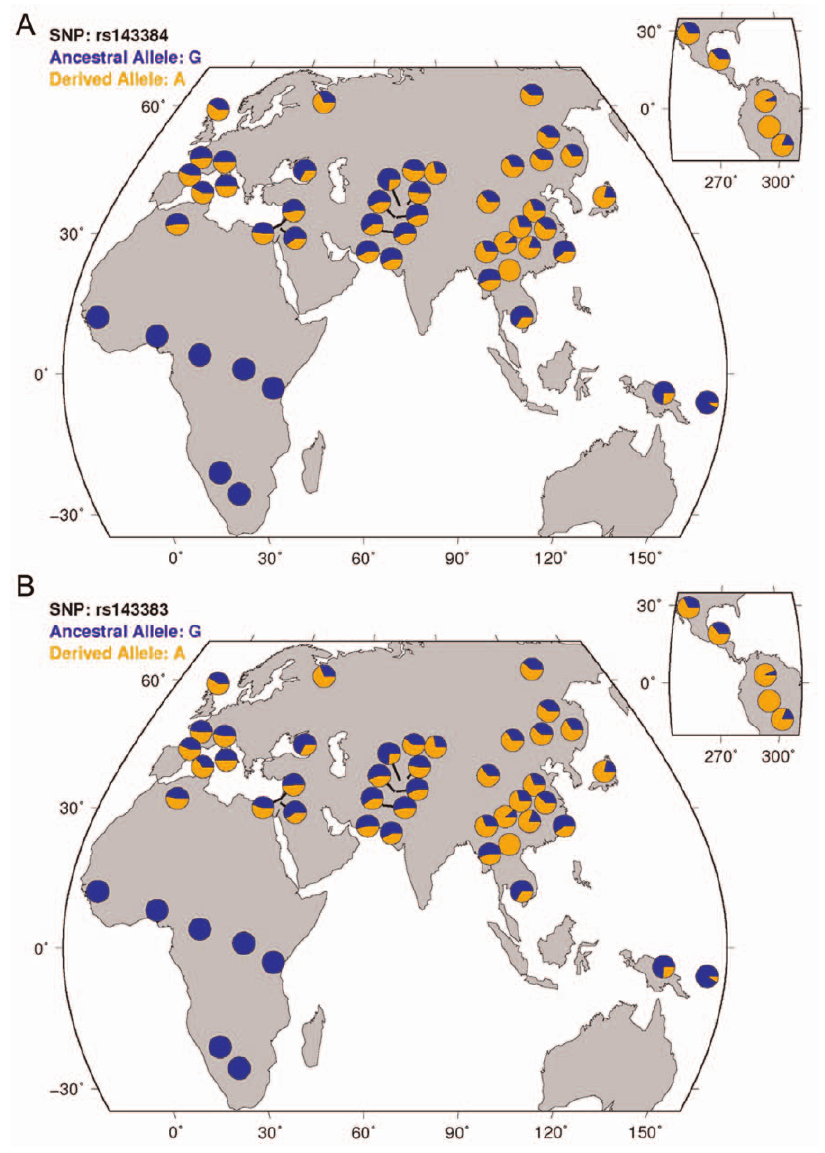
Figure 3. World-wide allele frequency distribution of the two SNPs rs143384 and rs143383. The data were downloaded from http:// hgdp.uchicago.edu/.